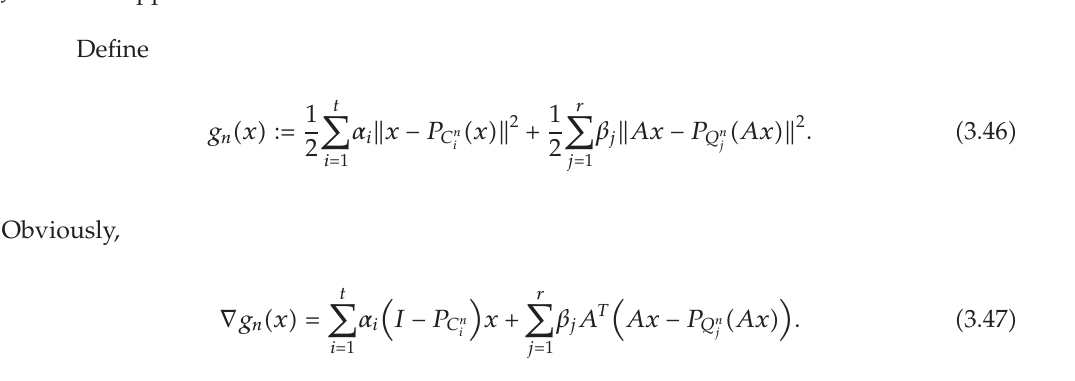
Algorithm 3.33. Given γ > 0 , ρ ∈ (cid:2) 0 , 1 (cid:3) , μ ∈ (cid:2) 0 , 1 (cid:3) let x 0 be arbitrary. For n (cid:8) 0 , 1 , 2 , . . . ,